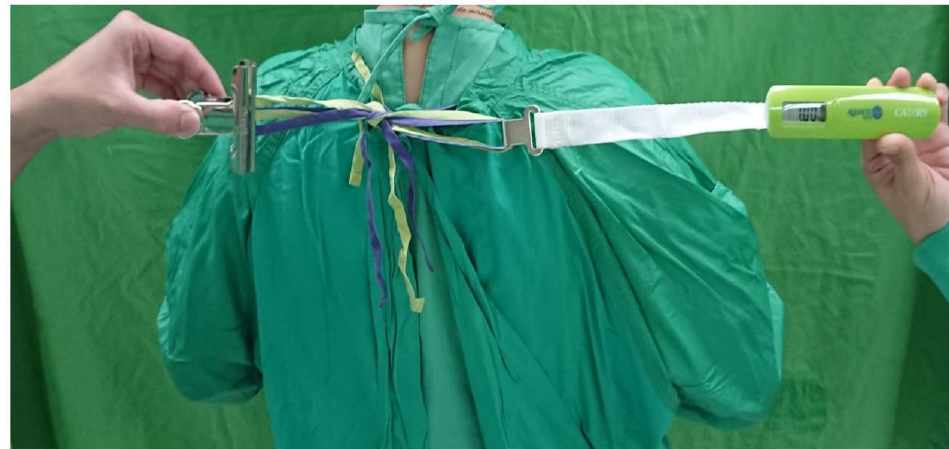
3 of 7 Figure 2. Illustration of the combined tie-fastening method for two sets of rear neck ties. 2. Materials and Methods This study was approved by the ethics committee of our institution (IRB number: CYCH-IRB No. 2020021). We conducted a prospective investigation to test the rear neck tie loosening of the separated tie and combined tie methods. The volunteer agreement was signed by all volunteers. We enrolled 5 volunteers (3 males, 2 females) who had at least a 5-year working experience in the operating room with a gown-wearing technique as their routine practice. We aimed to evaluate the tie loosening condition of the reusable surgical gowns with 2 sets of rear neck tie belts after a series